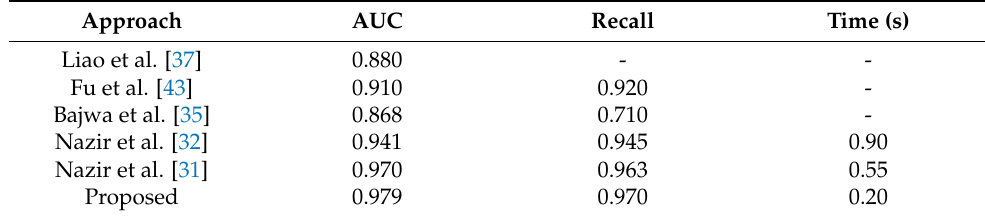
Table 4. Performance comparison with latest